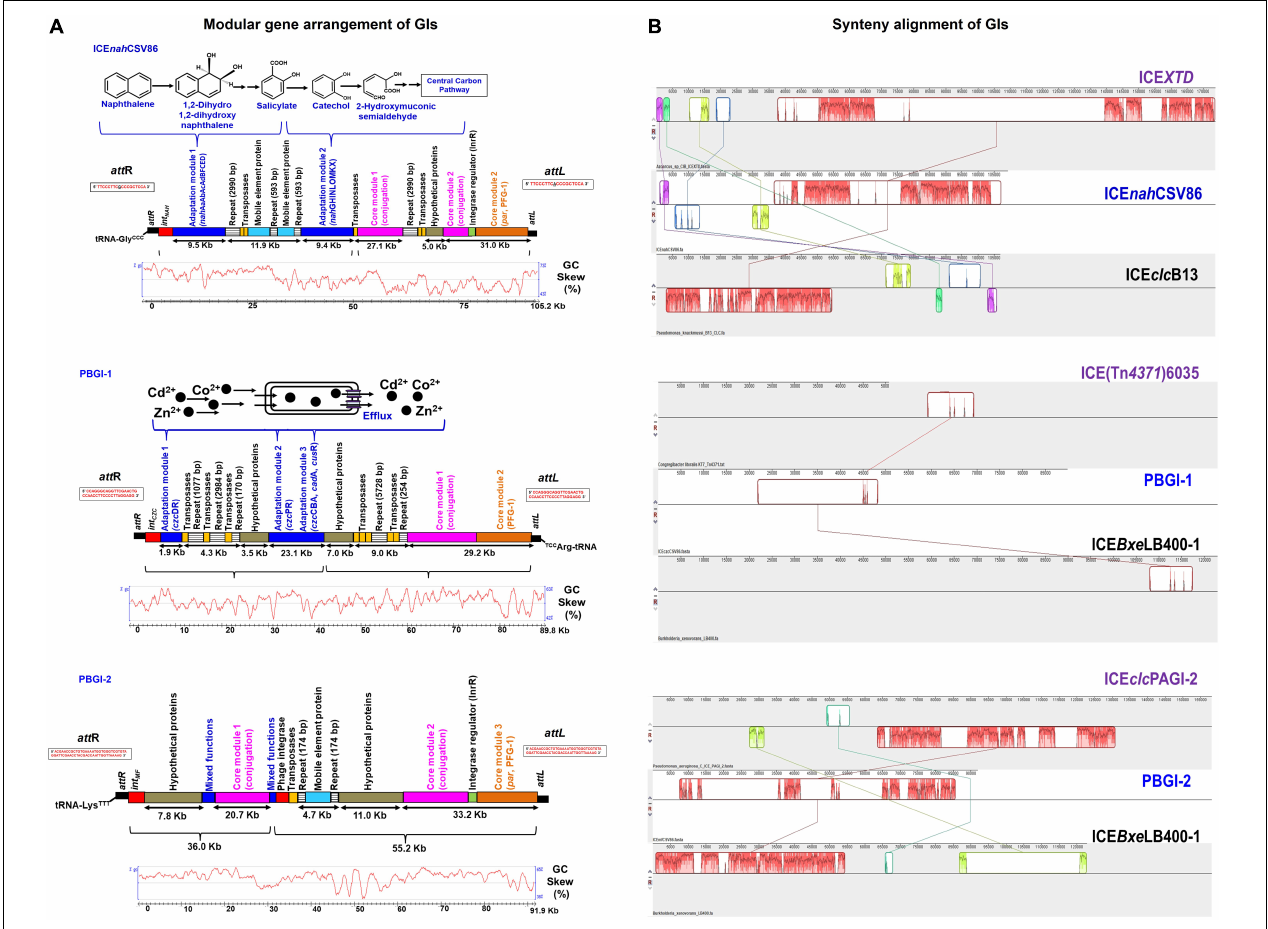
FIGURE 2 | Comparative analyses of the three full-length GIs: ICE nah CSV86, PBGI-1 and PBGI-2 from Pseudomonas bharatica CSV86 T . (A) Structural/modular organization of the three GIs, suspected to be ICEs. The color codes and depiction are as follows: cargo gene modules (blue), integration/excision (red), integrase regulator (green), conjugation (purple), partition modules (orange), regions containing repeats (lined boxes), genes encoding transposases (yellow), hypothetical proteins (gray), and mobile element proteins (light blue). Flanking att L and att R sites are indicated at the extreme ends (black solid rectangles) of the GIs and its sequences are depicted within the rectangular boxes. The functions encoded by respective cargo modules are depicted above the gene arrangement. The GC disparity plots (mol% skewness/deviations) for respective GIs are indicated below the gene arrangement. (B) Synteny alignment plots of predicted ICEs with the nearest similar ICEs from other bacteria obtained using progressive MAUVE alignment method. The blocks in different colors indicate linear conserved blocks (LCBs) and criss-cross connecting lines indicate the homologous LCBs amongst ICEs. For gene annotation and ORF details, refer to Supplementary Tables 3 – 5 .